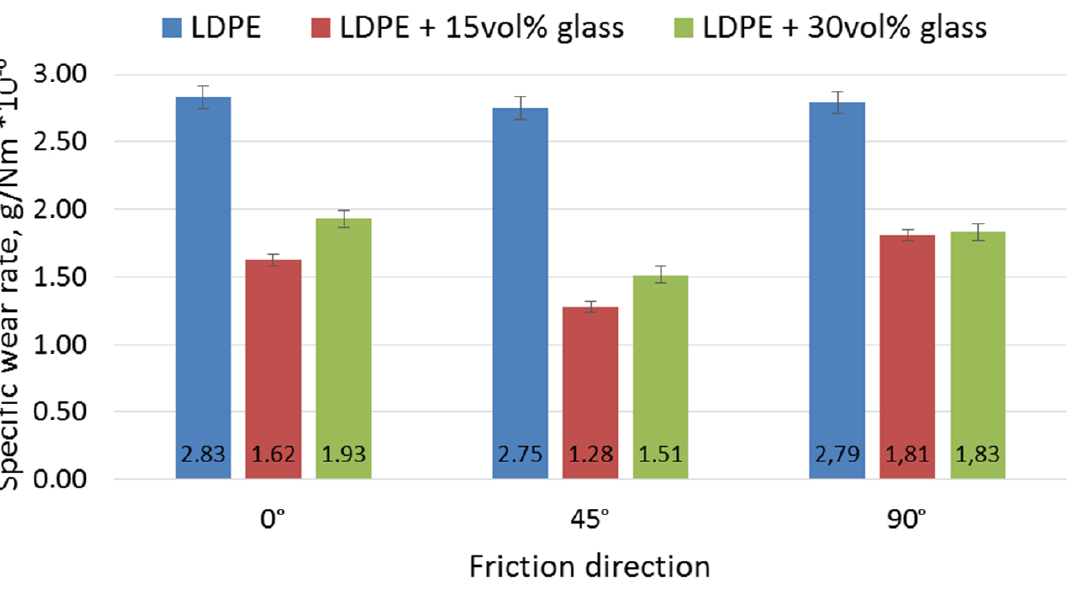
Figure 10. Calculated specific wear rate for examined materials: neat LDPE and the composites.